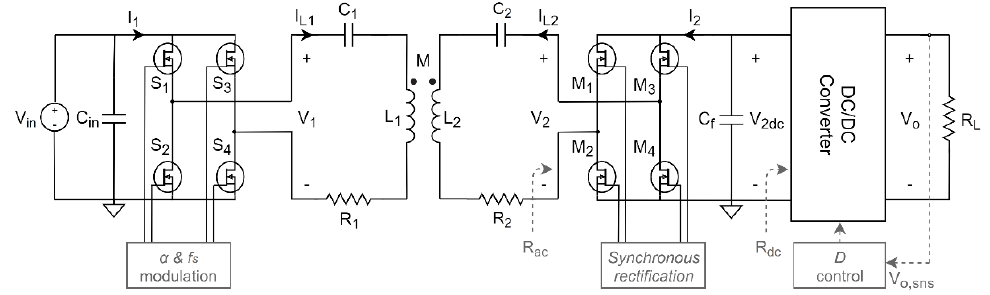
Figure 9. Series – series post-regulated IPTS schematic.